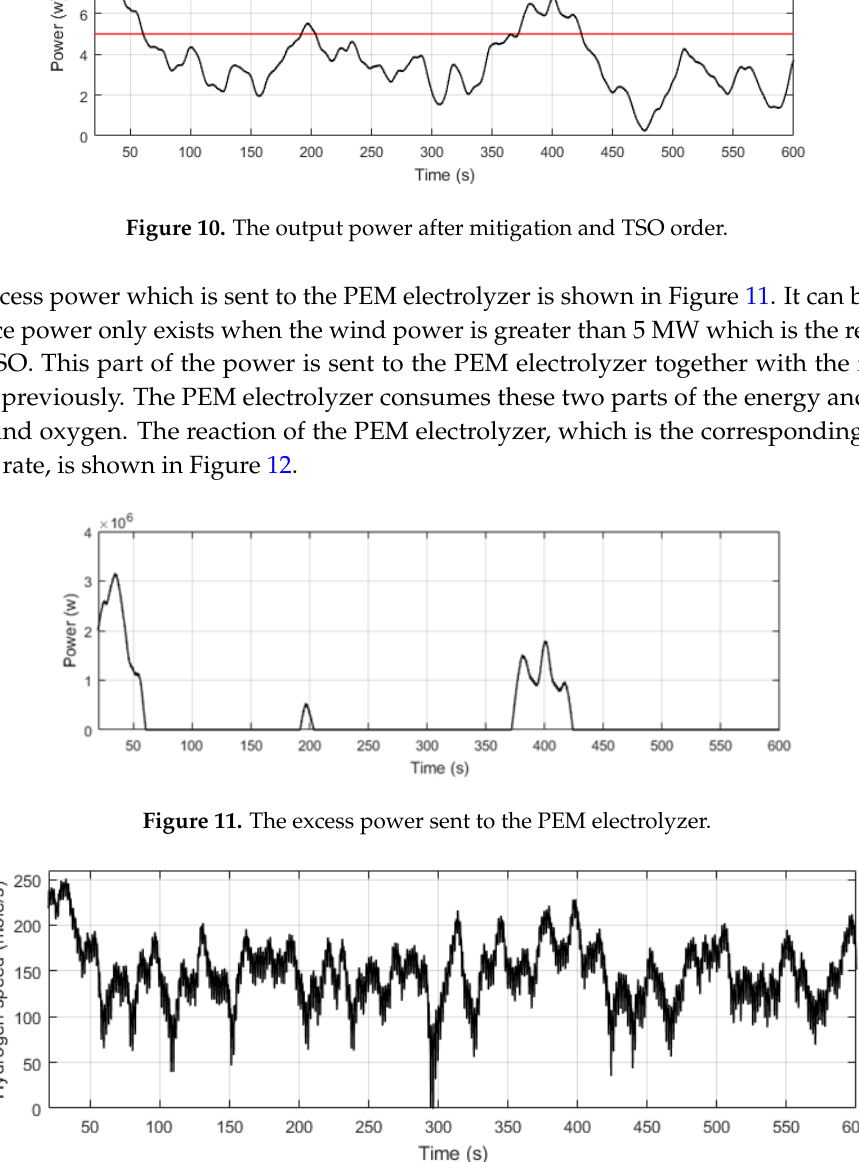
Figure 12. The hydrogen production rate.